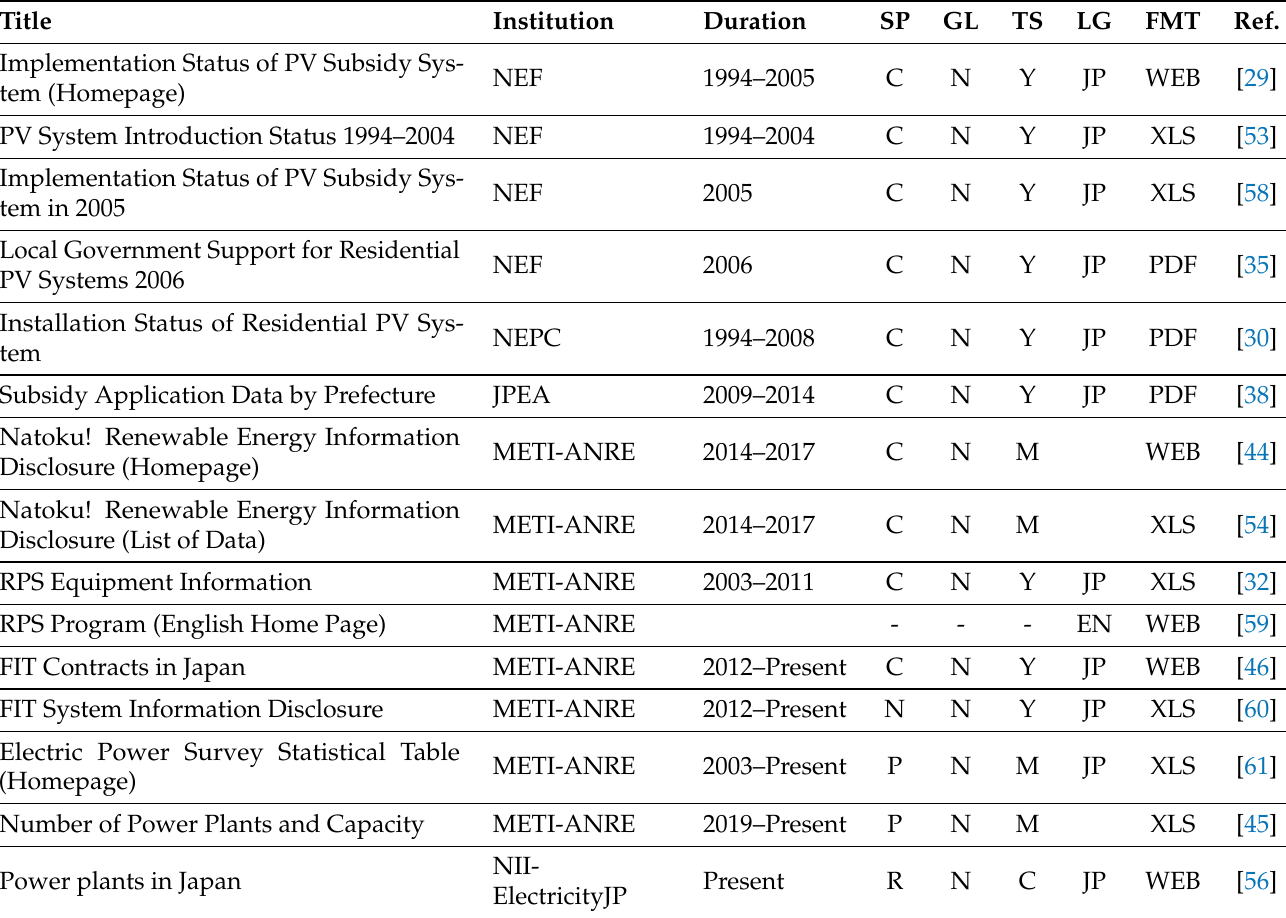
Table 6. Solar PV capacity